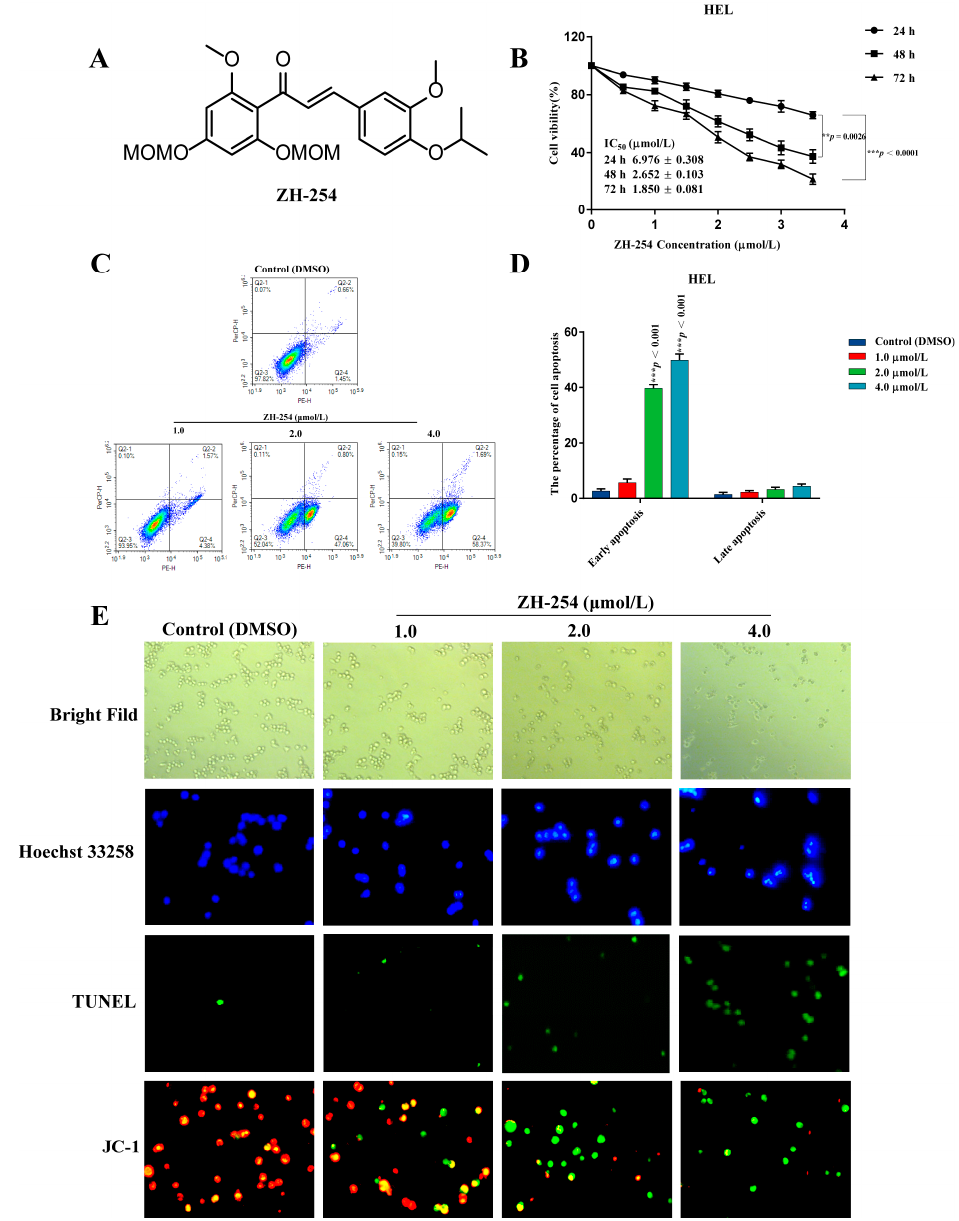
Figure 1. ZH-254 induced inhibition of HEL cell proliferation and apoptosis. ( A ) Chemical structure of ZH-254. ( B ) Cell viability curves of HEL cell growth after ZH-254 treatment by MTT assay. ( C ) The apoptosis-inducing effect of different concentrations of ZH-254 on normal HEL cells was detected by flow cytometry. ( D ) Comparison of the effects of ZH-254 on the early and late apoptosis rates of HEL cells; ( E ) Microscopic observation of the cell state of HEL cells after treatment with ZH-254 for 48 h; ZH-254 induced apoptosis as visualized by Hoechst 33258 (Beyotime, Shanghai, China); ZH-254 induced apoptosis as visualized by TUNEL (Beyotime, Shanghai, China); effect of ZH-254 on the membrane potential of human erythroleukemia HEL cells. The above images are all magnified at 200×. The data are presented as mean ± SEM. ** p < 0.01, *** p < 0.001.